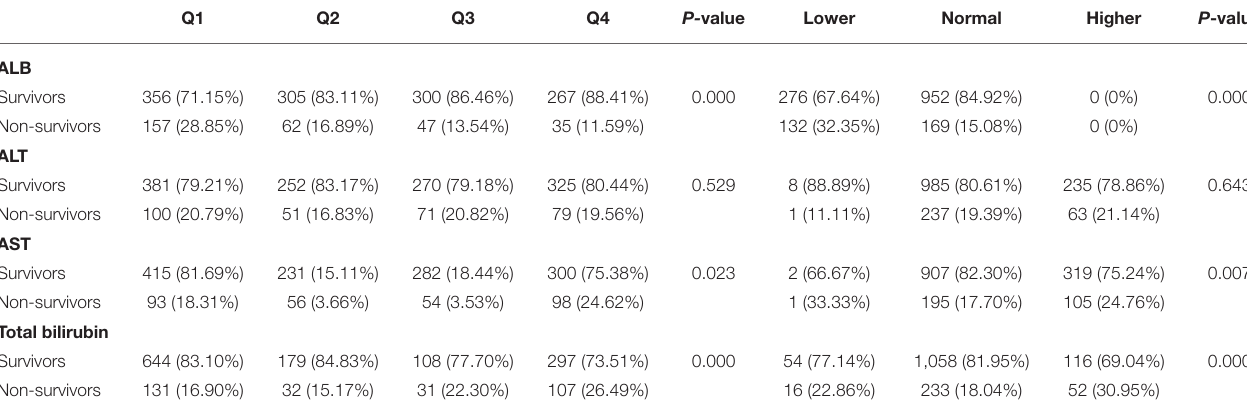
TABLE 5 | The relationship between ALB, ALT, AST, and total bilirubin with 4-year